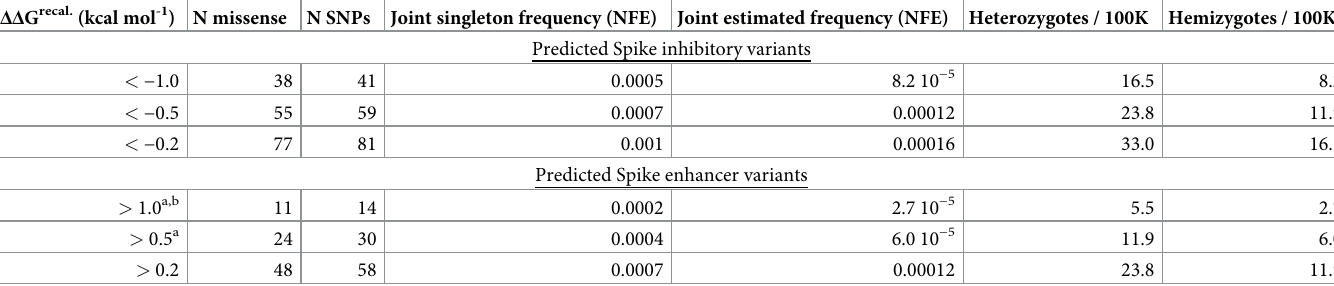
Table 3. Estimated allele frequencies of potential novel variants in ACE2 with predicted Spike binding phenotypes. The estimate is calculated from the observed occurrence of rare variants in ACE2 in gnomAD [24] (6.1 × 10 − 6 ) and the proportion of SNPs at the 25 residues that are predicted to modify Spike affinity at different thresholds (see